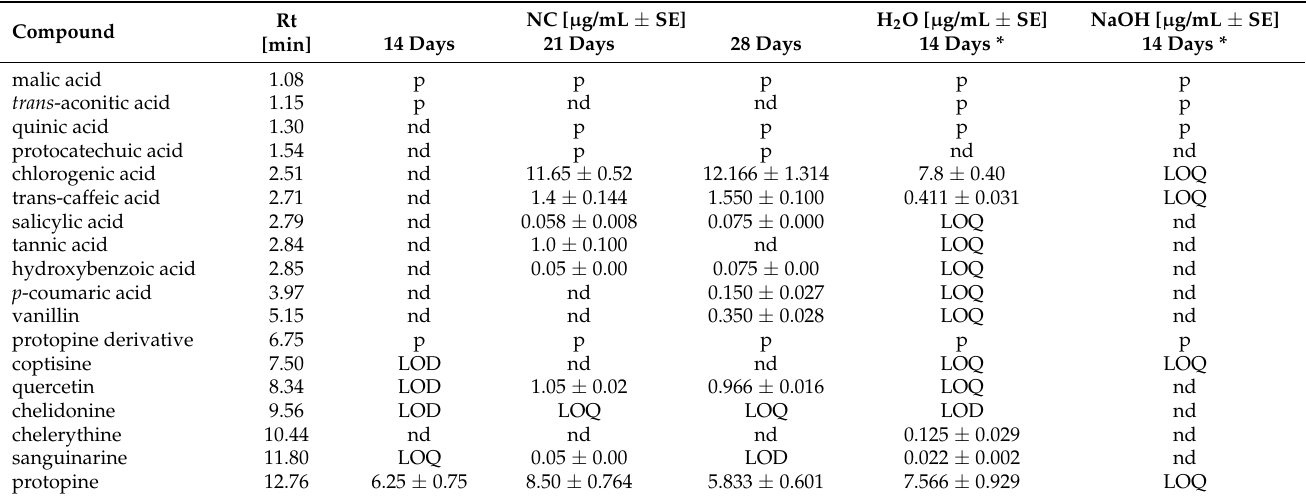
Table 2. LC-MS/MS analysis of the content of the detected compounds and their retention times (Rt) in 3-day-old cellulose (NaOH, H 2 O, NC) with C. majus cells cultured on MH3 medium for 14, 21 and 28